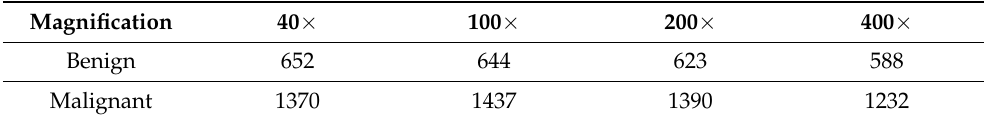
Table 1. Summary of image distribution for different magnification factors.